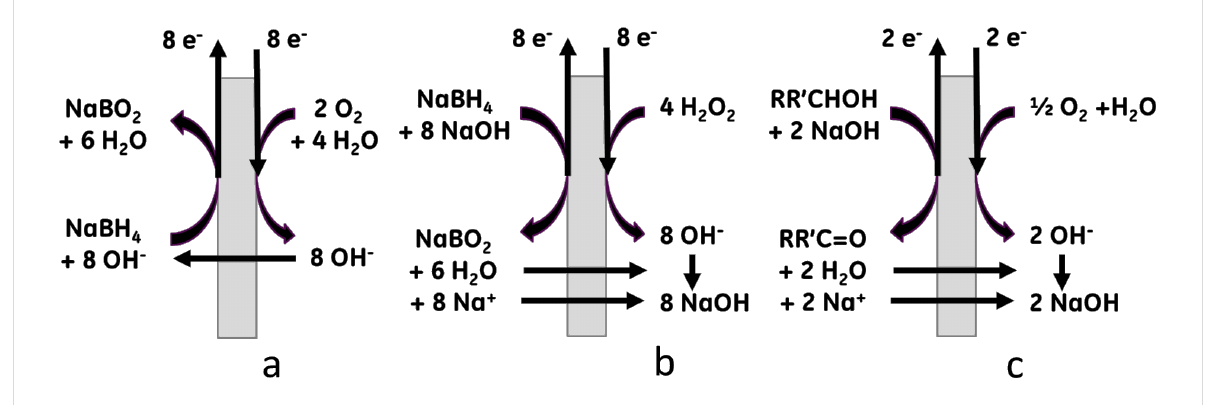
Figure 2: The electrochemistry of a borohydride liquid fuel cell with hydroxyl (a) and cation (b) exchange membranes and an alcohol fuel cell with cation exchange membrane (c).